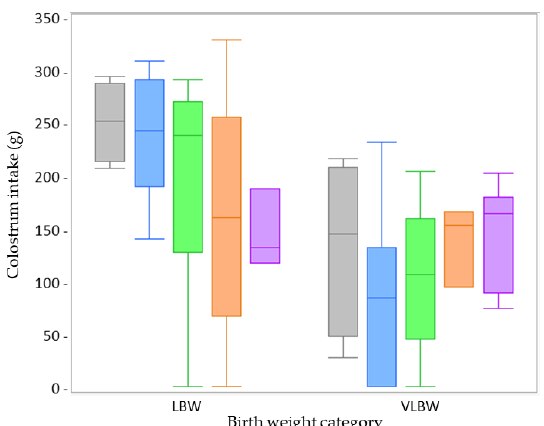
Figure 2. Boxplots of the colostrum intake at Farm A from low birth weight (LBW; n = 38) and very low birth weight (VLBW; n = 33) piglets per treatment (dense milk replacer [DMR] one dose [grey box; LBW n = 4, VLBW n = 5], DMR three doses [blue box; LBW n = 11, VLBW n = 9], no treatment [green box; LBW n = 9, VLBW n = 6], sham one dose [orange box; LBW n = 11, VLBW n = 3], sham three doses [purple box; LBW n = 3, VLBW n = 10]). There was no effect of treatment on colostrum intake ( p = 0.575). Irrespective of treatment, colostrum intake was significantly less in VLBW when compared to LBW piglets ( p = 0.001).